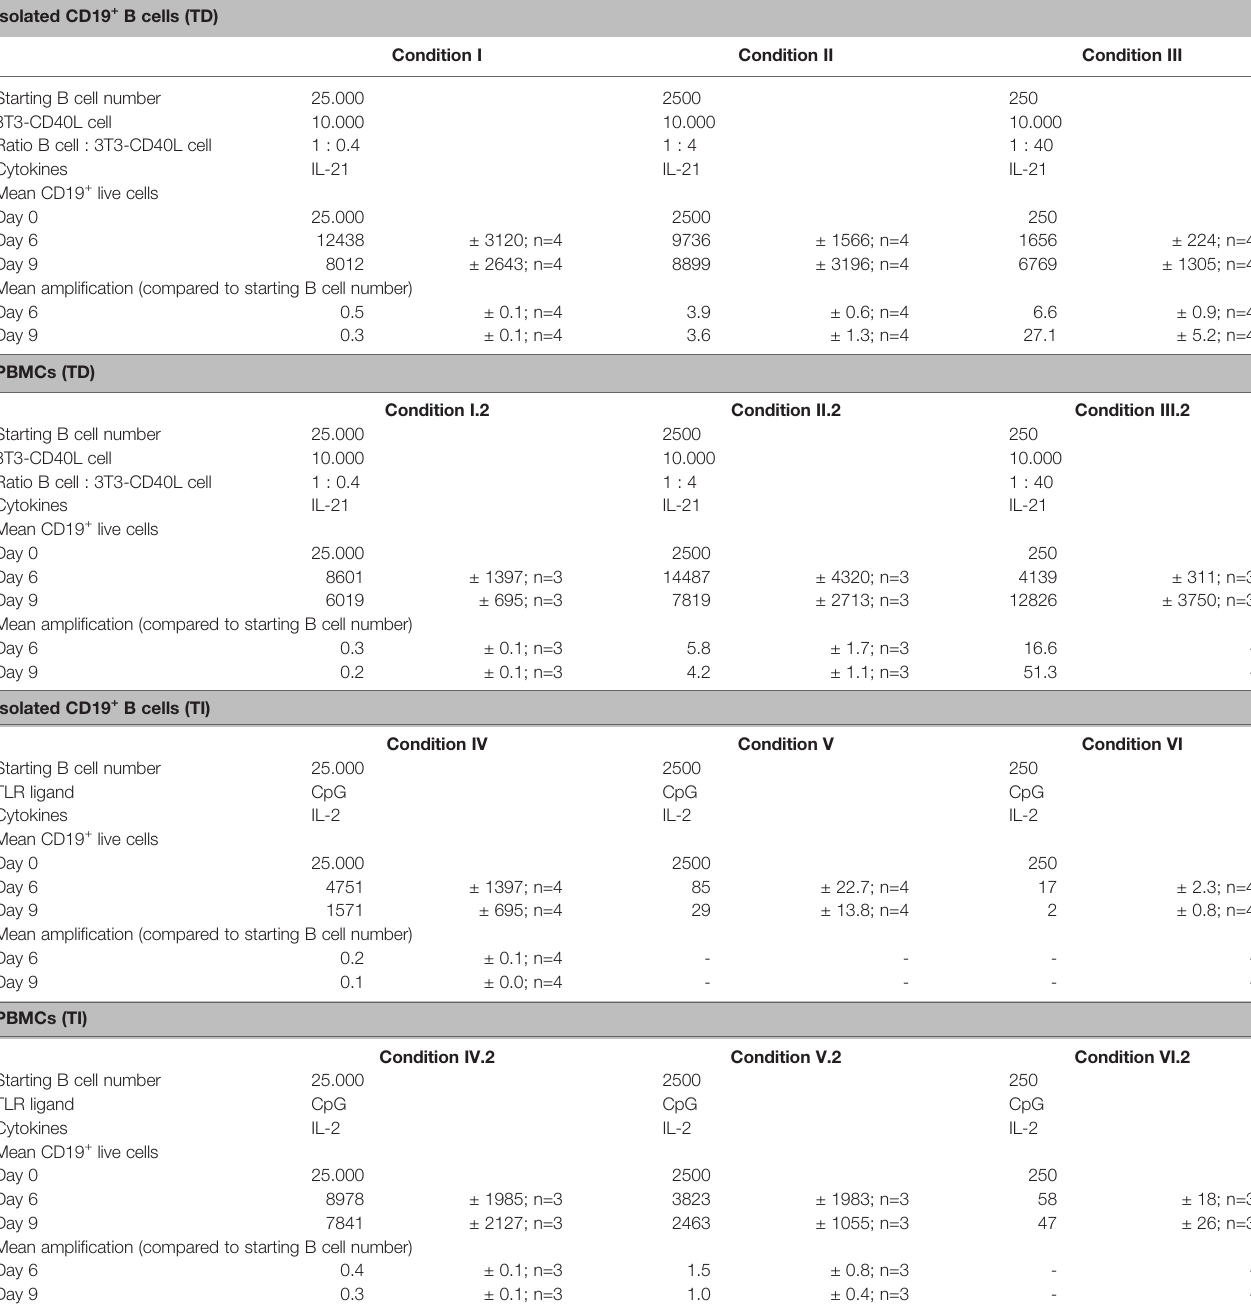
TABLE 3 | B cell survival and proliferation during different B cell differentiation